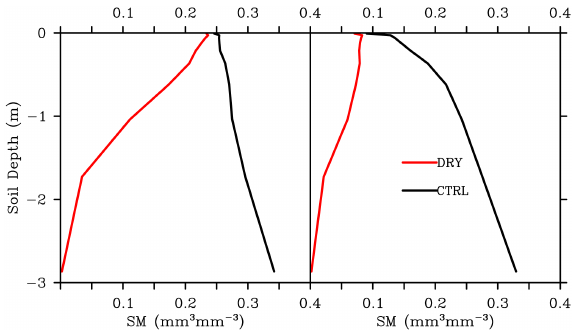
Figure 5. Spatiotemporal mean soil moisture (mm 3 mm − 3 ) SM as a function of depth (m) for (a) DJF and (b)